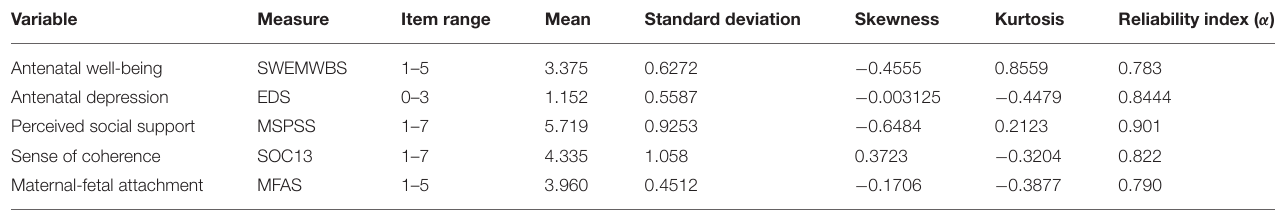
TABLE 1 | Summary of scales used to measure antenatal well-being, antenatal depression, perceived social support, sense of coherence and maternal-fetal attachment.